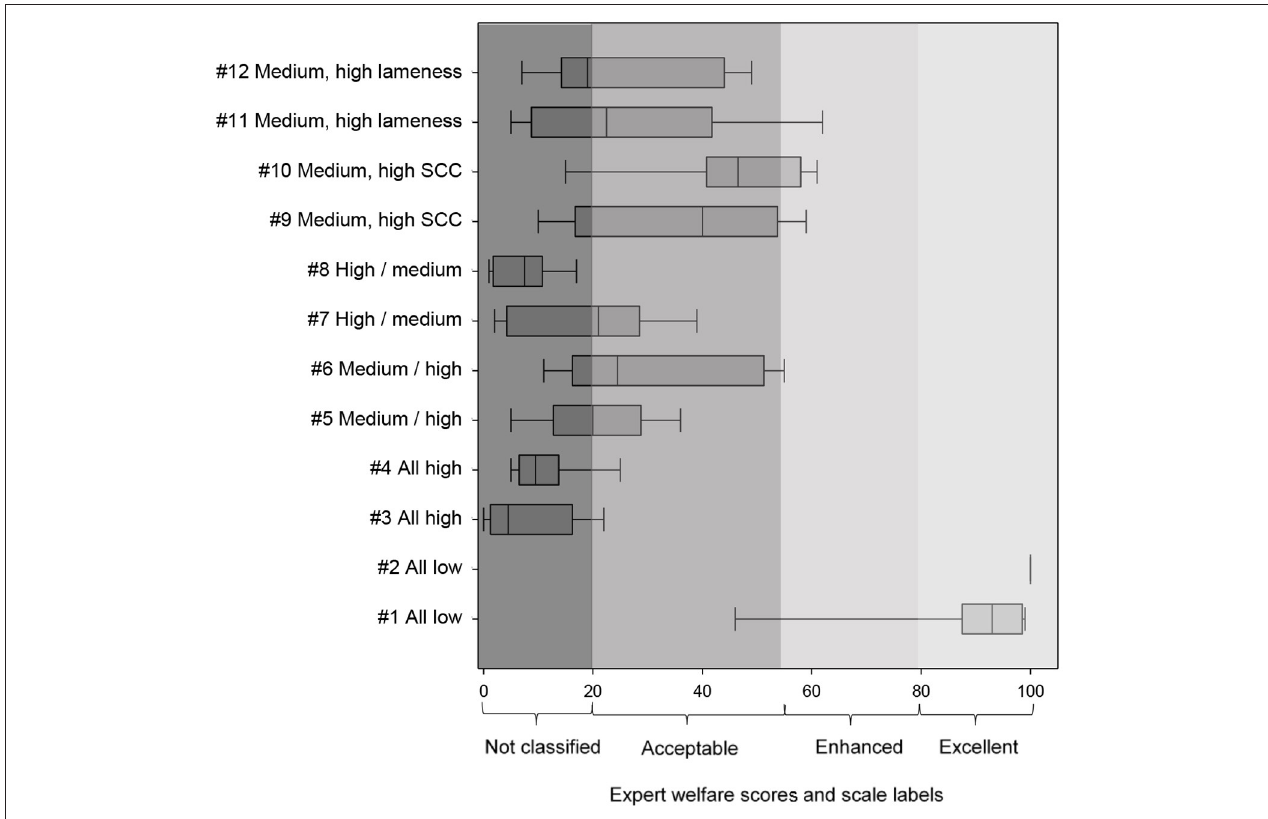
FIGURE 4 | Medians and interquartile range (box) of the welfare scores allocated by experts (n = 14) to the 12 focus farms (confer Table 2 ) using a 0–100 tagged Visual Analog Scale. Whiskers: data within 1.5 × the interquartile range. Higher scores imply better welfare. QBA, Qualitative Behavior Assessments. Highest scores belonged to the top 5% of herds in the European dataset (n = 491), medium between 40 and 60%, and lowest scores were from the lowest 5% of herds. 1 “% of too lean cows,” “SCC > 400,000,” and “number of hairless patches” were high, 2 “% of cows with lesions,” “% of cows with severe lameness,” and “% of mortality” were high.